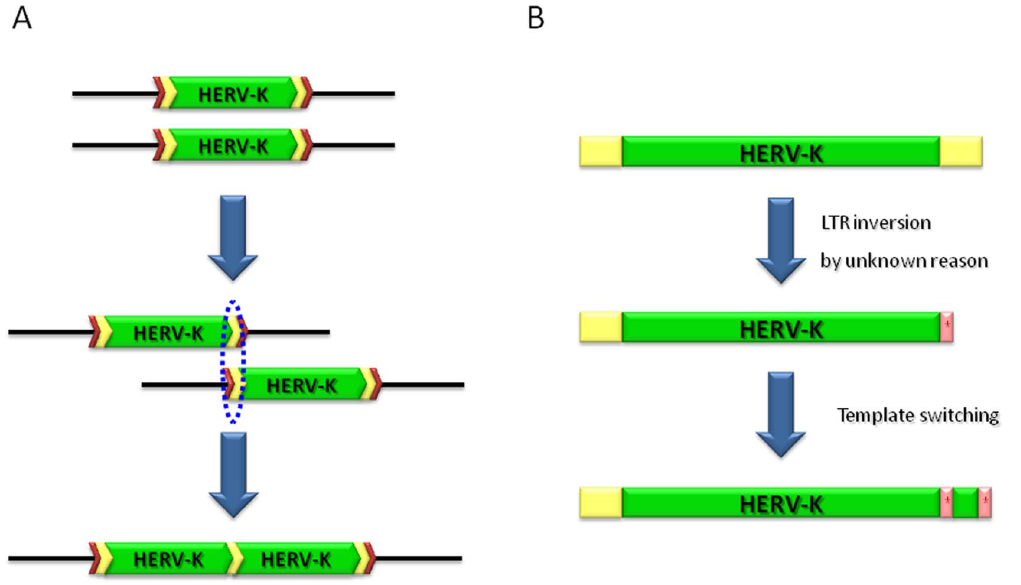
Figure 1. Comparison of human-specific HERV-K108 and HERV-K124 elements. Both of HERV-K108 and HERV-K124 have two HERV-K internal regions (green). However, their sequence architecture is the result of different mechanisms. (A) HERV-K108. After the insertion of the HERV-K element, non-allelic homologous recombination between two different LTRs (yellow chevrons) of the HERV-K element occurred. This resulted in a locus containing two HERV-K internal regions and three LTRs. This locus retains the original TSDs (red chevrons) created upon its initial insertion. (B) HERV-K124. Compared to the HERV-K108, which has two intact internal regions and three intact LTRs, the second internal region of HERV-K124 has largely deleted and its internal and 3 9 LTRs inverted and partially deleted. The mechanism(s) responsible for this element’s sequence architecture is not clearly resolved, but we depict here a potential mechanism capable of generating this element. Yellow boxes indicate standard LTRs, pink boxes indicate inverted partial LTRs, and green boxes indicate HERV-K internal